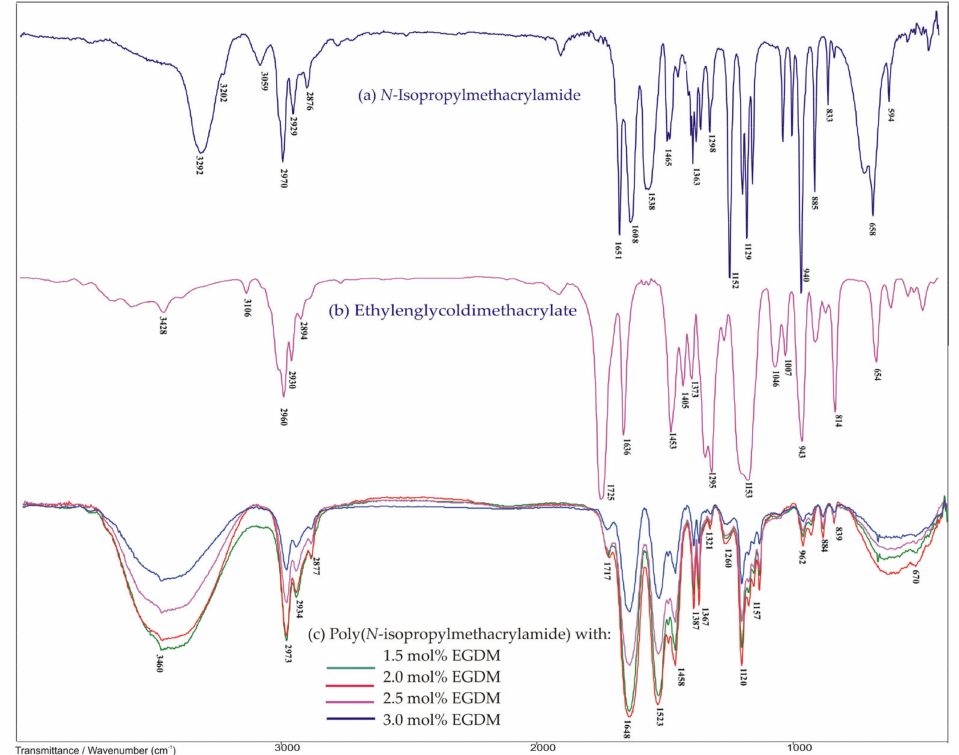
Figure 2. FTIR spectra: ( a ) N -isopropylmethacrylamide, ( b ) ethylene glycol dimethacrylate, and ( c ) synthesized poli( N -isopropylmethacrylamide) samples with 1.5, 2.0, 2.5, and 3.0 mol% of ethylene glycol dimethacrylate